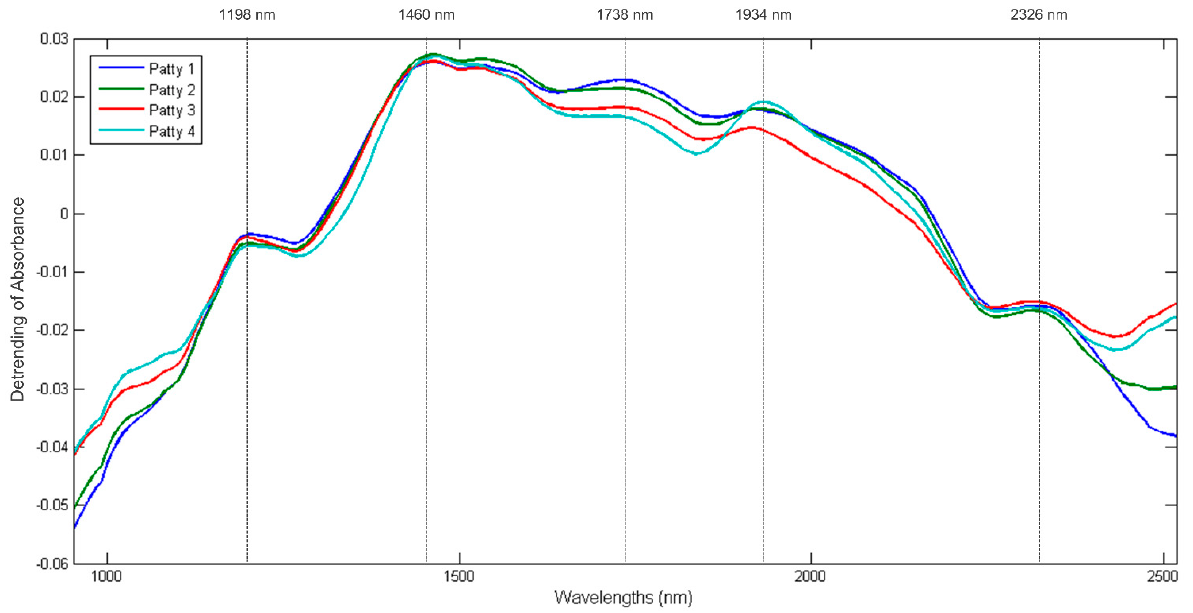
Figure 6. Baseline corrected (detrending) mean pseudo ‐ absorbance spectra for Patty 1 ( blue ), Patty 2 ( green ), Patty 3 ( red ) and Patty 4 ( turquoise ); Five prominent absorption bands were observed at 1198 (fat), 1460 (moisture), 1738 (fat), 1934 (moisture) and 2326 nm (protein).